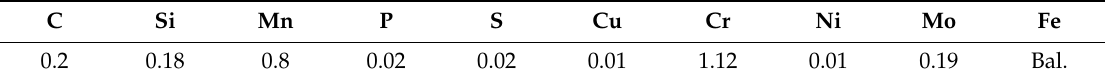
Table 1. Chemical composition of SCM420H